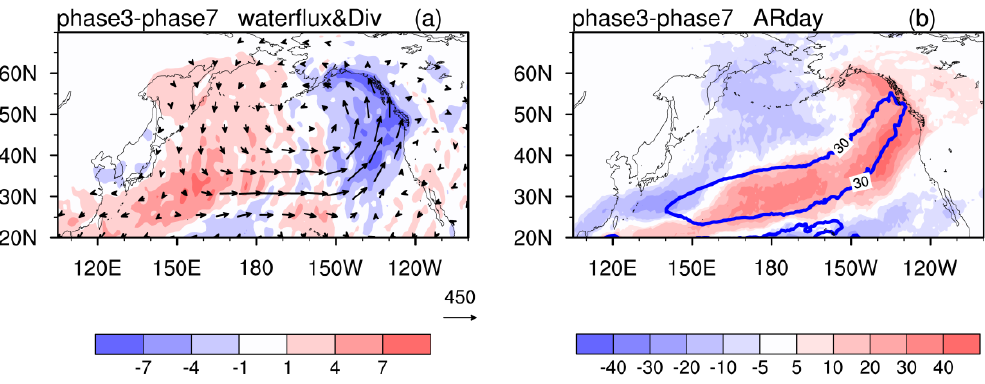
Figure 10. ( a ) Moisture transport (vector; kg m −1 s −1 ) and its convergence (shaded areas; kg m −2 d −1 ) difference between phases three and seven. ( b ) AR frequency (%) difference between phases three and seven.